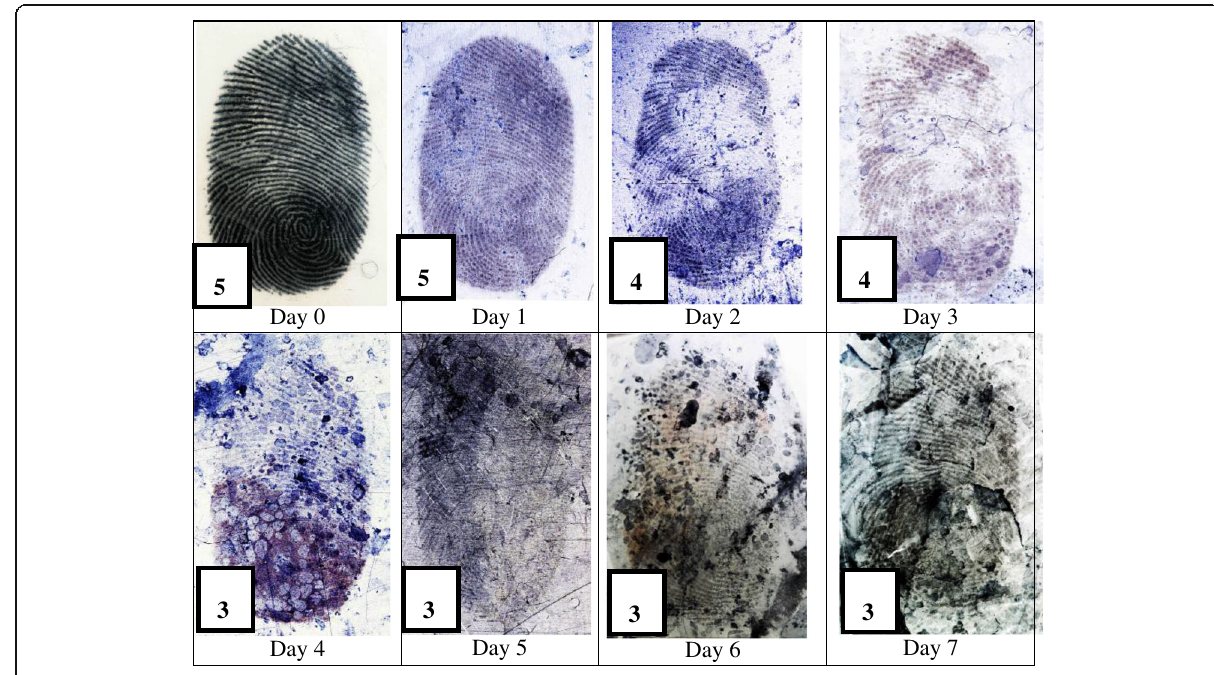
Fig. 9 Developed fingermarks using Sudan black